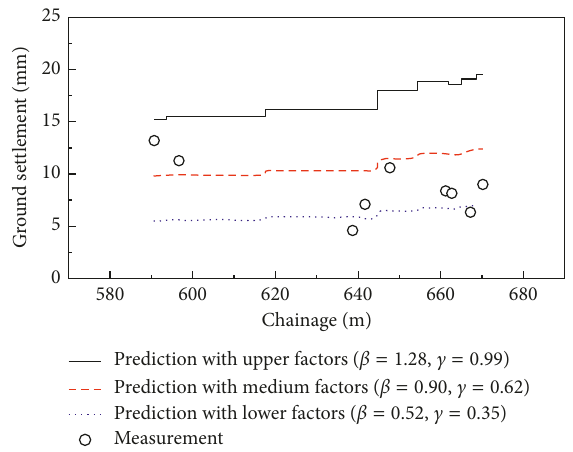
Figure 10: Comparison of ground settlement between measure- ment and predictions